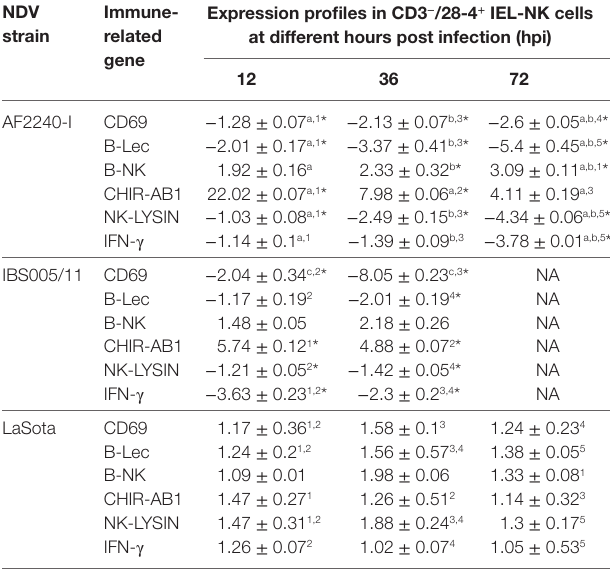
TaBle 4 | Relative folds change expression profiles of immune-related genes associated with NK cell activity of CD3 − /28-4 + IEL-NK cells following Newcastle disease virus (NDV)